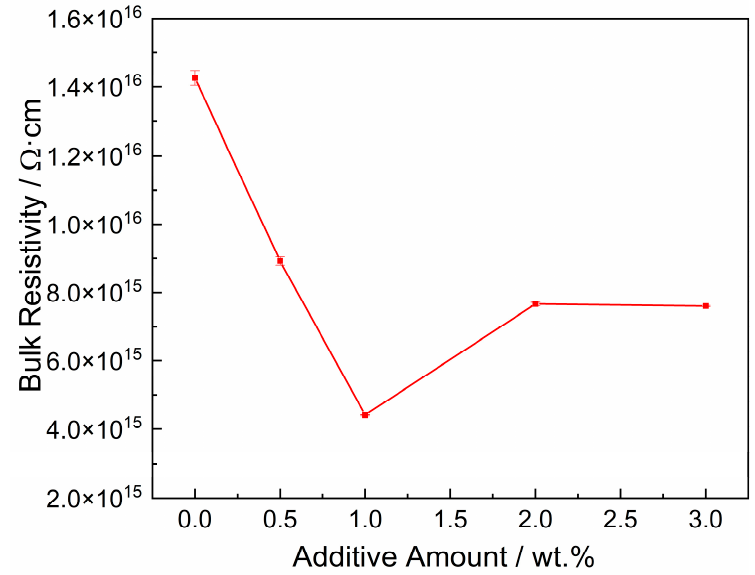
Figure 13. Bulk resistivity of PI films with different amounts of